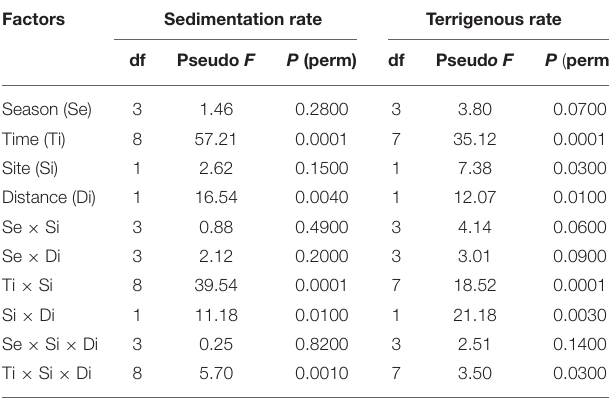
TABLE 1 | Results of a permutational analysis of variance (PERMANOVA) sedimentation rate and terrigenous rate.